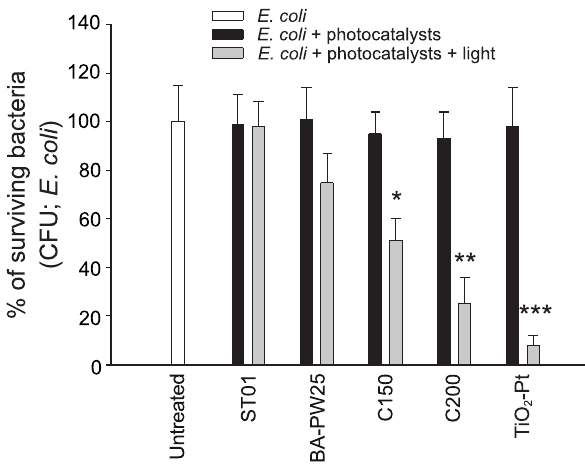
Figure 1. Antibacterial activity of nanoscale TiO 2 -Pt. The antibacterial activity of TiO 2 -Pt-mediated photocatalysis against E. coli is compared with other UV and visible light-responsive photocatalysts. The bacterial number (CFU) in the untreated groups was normalized to 100%. * P , 0.05, ** P , 0.01 and *** P , 0.001, compared to the respective groups without light. n=6 (3 experiments with 2 replicates). The data are presented as mean 6 SD.